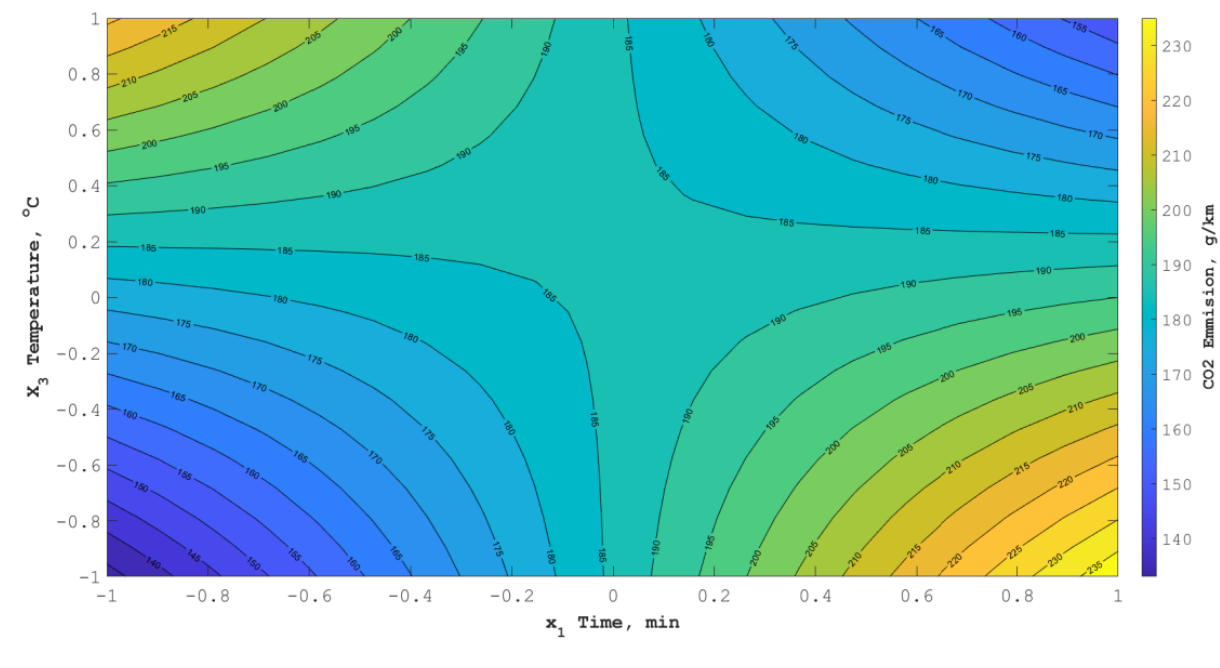
Figure 14. Change in CO 2 emissions depending on the variability of factors x 1 and x 3 for a vehicle (EV) covering a distance of 2 km (x 2 = −1 ).